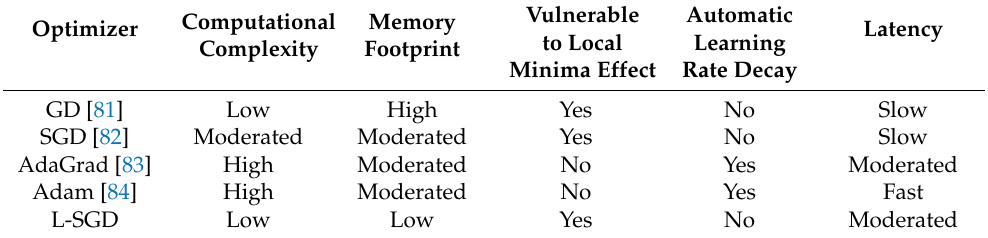
Table 8. Training algorithms—Gap